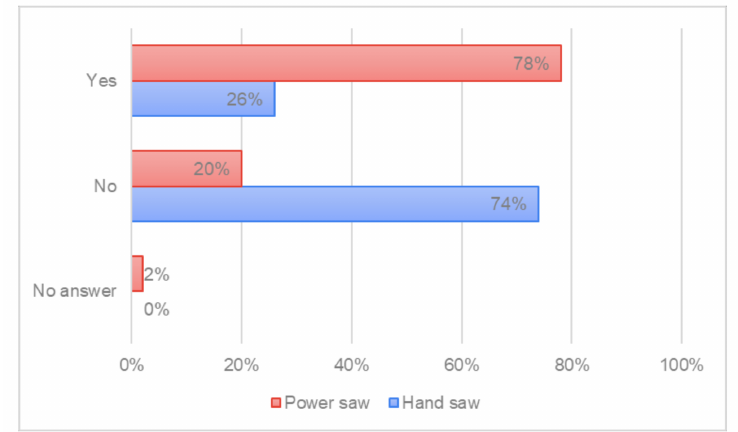
Figure 10. Frequency of injuries to tree climbers due to broken branch.